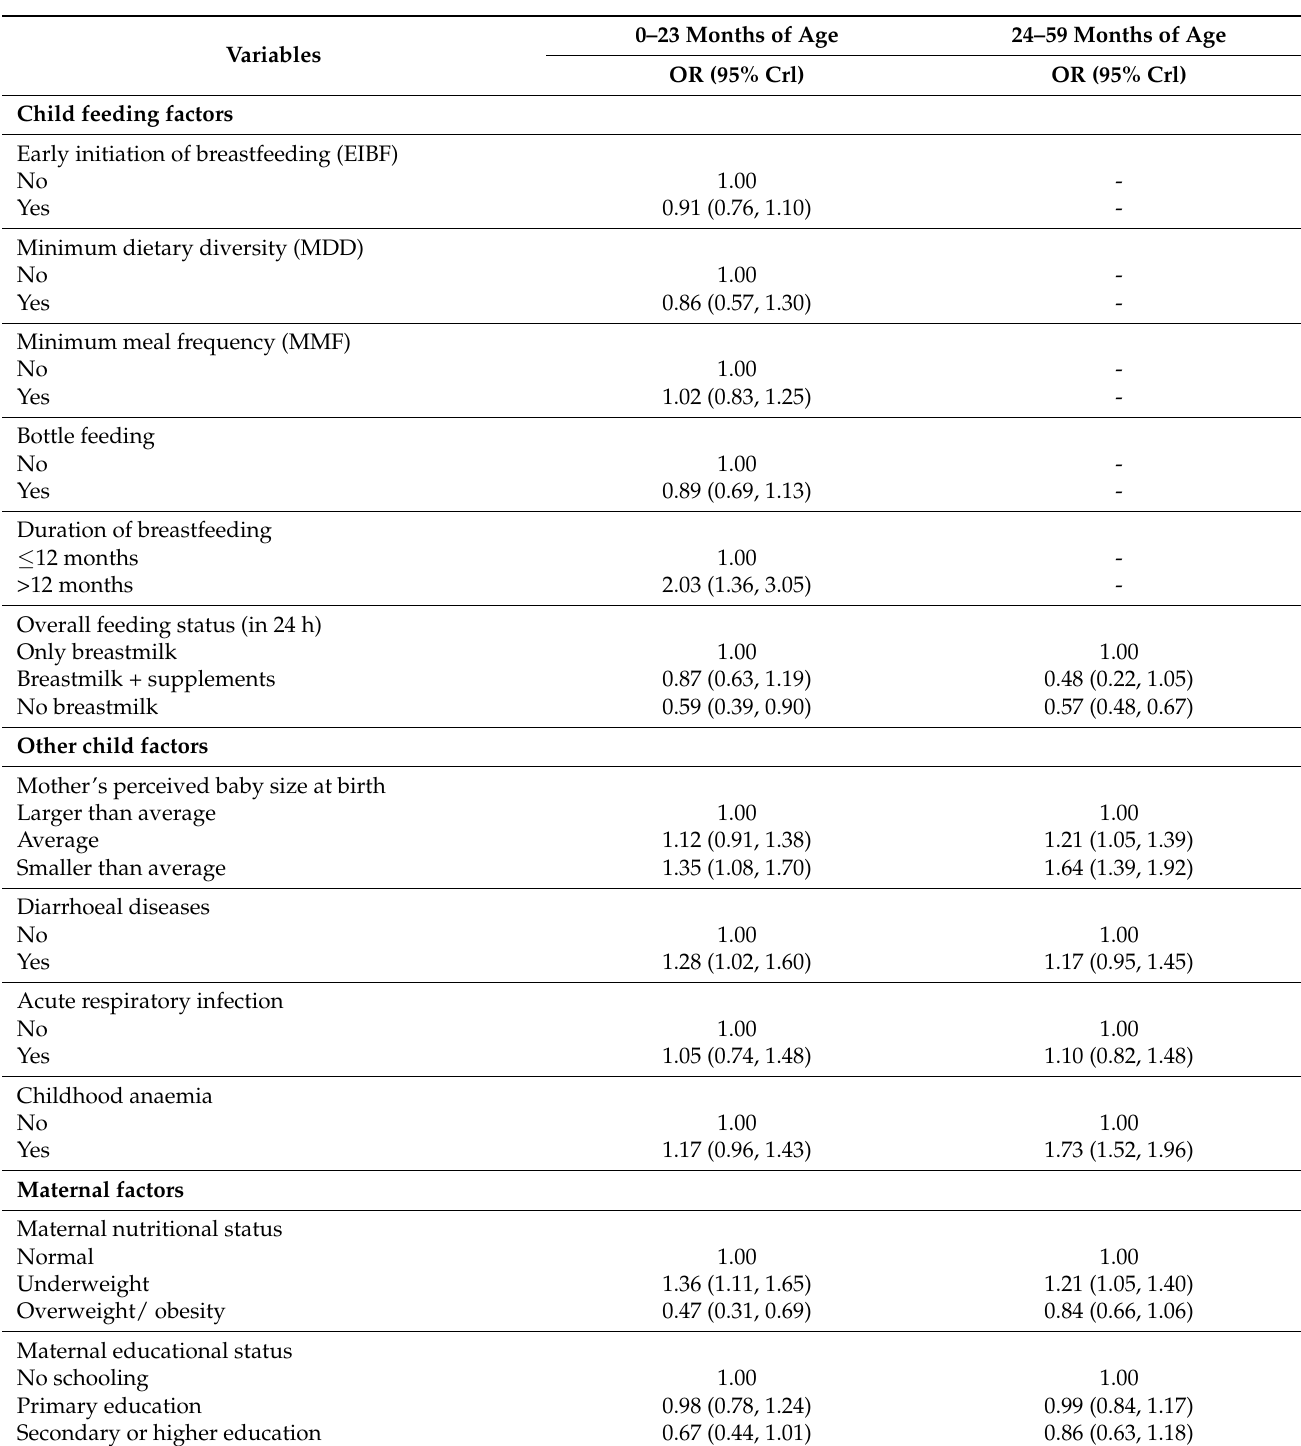
Table 2. Geospatial modelling for proximal and contextual determinants of stunting among children under five years of age in Ethiopia, 2016 EDHS ( n =